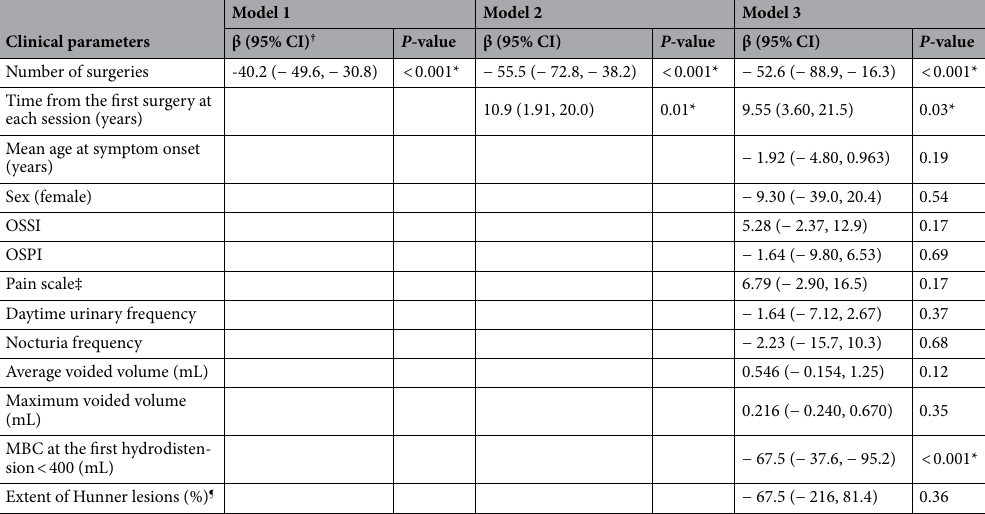
Table 2. Results of mixed-effect linear regression analyses for MBC against clinical parameters. † β regression coefficient, CI confidence interval (95%), MBC maximum bladder capacity, OSSI/OSPI O’Leary-Sant symptom index and problem index. ‡ Assessed using an 11-point pain intensity numerical rating scale from 0, indicating no pain, to 10, indicating the worst pain imaginable. ¶ Defined as the relative bladder luminal surface area of Hunner lesions at surgery (Ref. 25 ). * P < 0.05, statistically